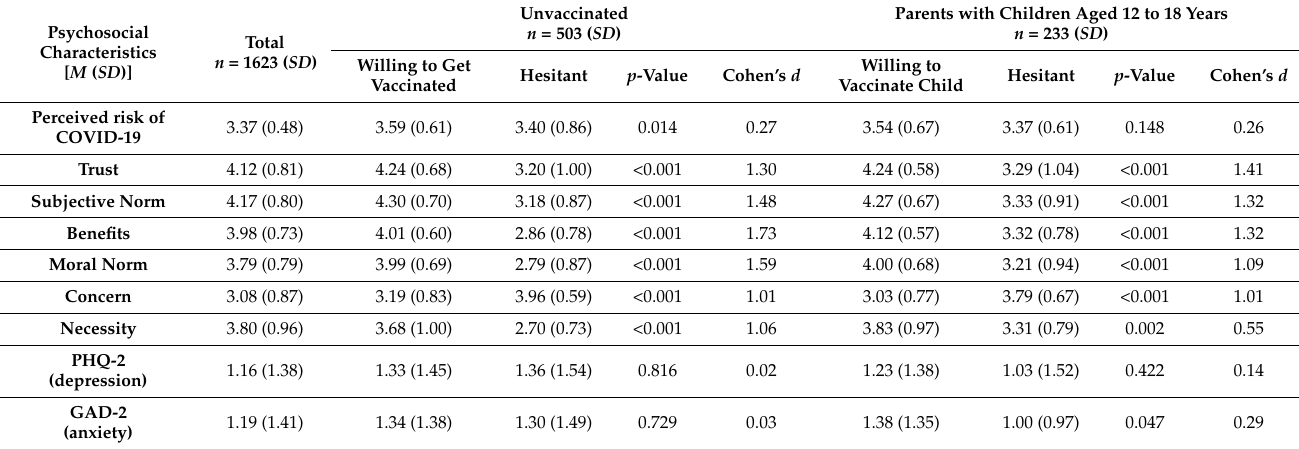
Table 2. Mean scores and standard deviation of all participants on psychosocial, anxiety and depression variables.